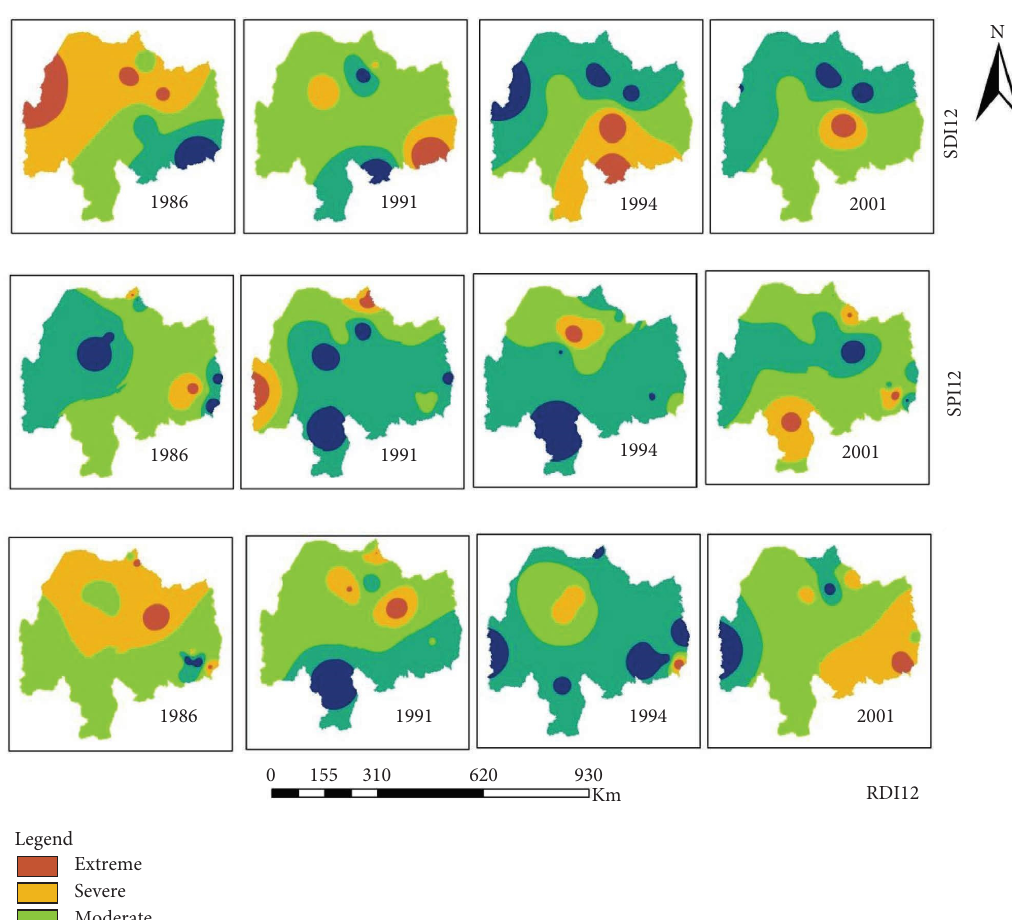
Figure 7: Spatial distribution of hydrometeorological drought in the Abbay river